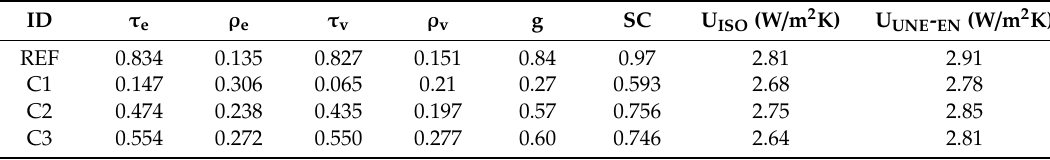
Figure 3. Studied configurations: ( a ) ETFE + ETFE; ( b ) ETFE + OPV / ETFE; ( c ) ETFE + OPV(50%) / ETFE; ( d ) ETFE + ETFE-SILVER(50%). Table 6. Summary of luminous, solar, and thermal characteristics of the Table 5. ID of configurations.